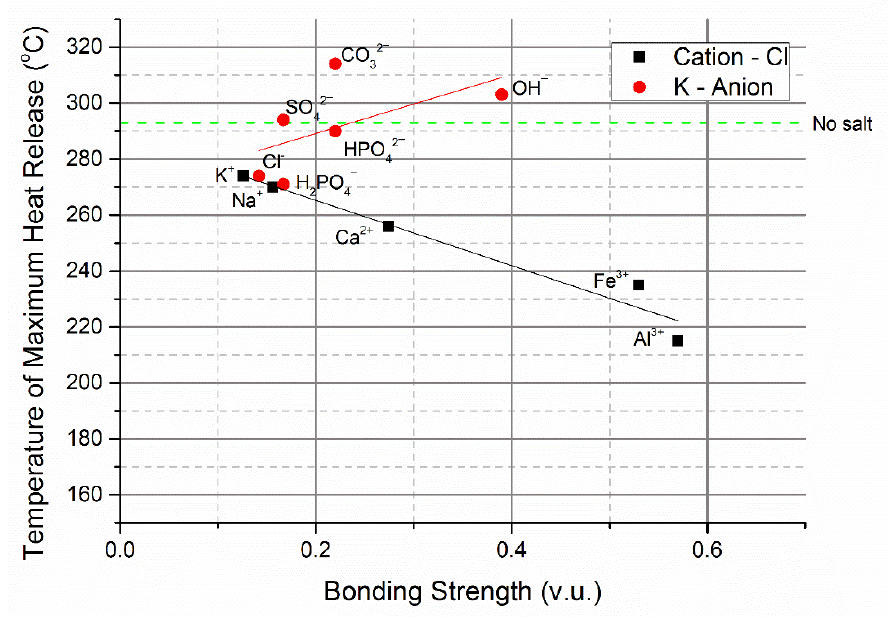
Figure 2. The correlation between ion bonding strength and temperature of maximum heat release determined by DSC. Green dashed line denotes the temperature of maximum heat release when no salt was added. The bonding strength equals valency divided by ideal coordination number [63]. The concentration of K + and Cl − was 1 mol/L, where applicable, except for KOH, FeCl 3 and AlCl 3 which were added at concentrations of 0.1 mol/L. Fits for both sets of salts produced via linear regression.